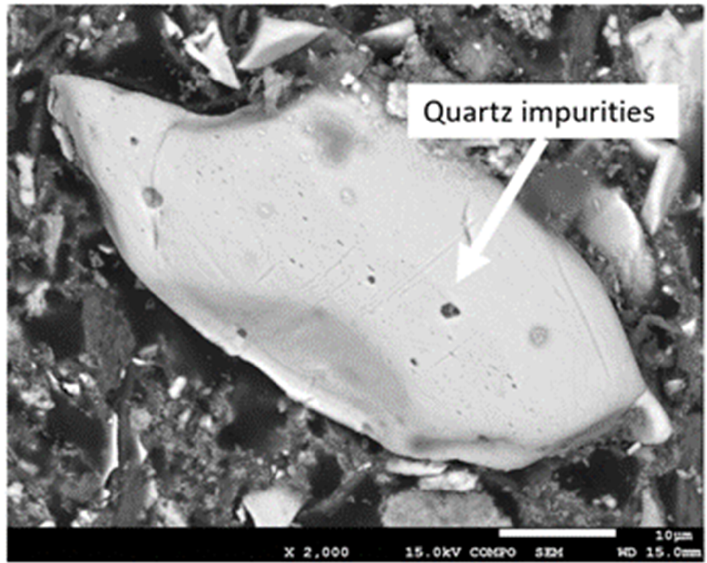
Figure 4. Selected image of the surface of a hematite with finely dispersed quartz (sample 1).